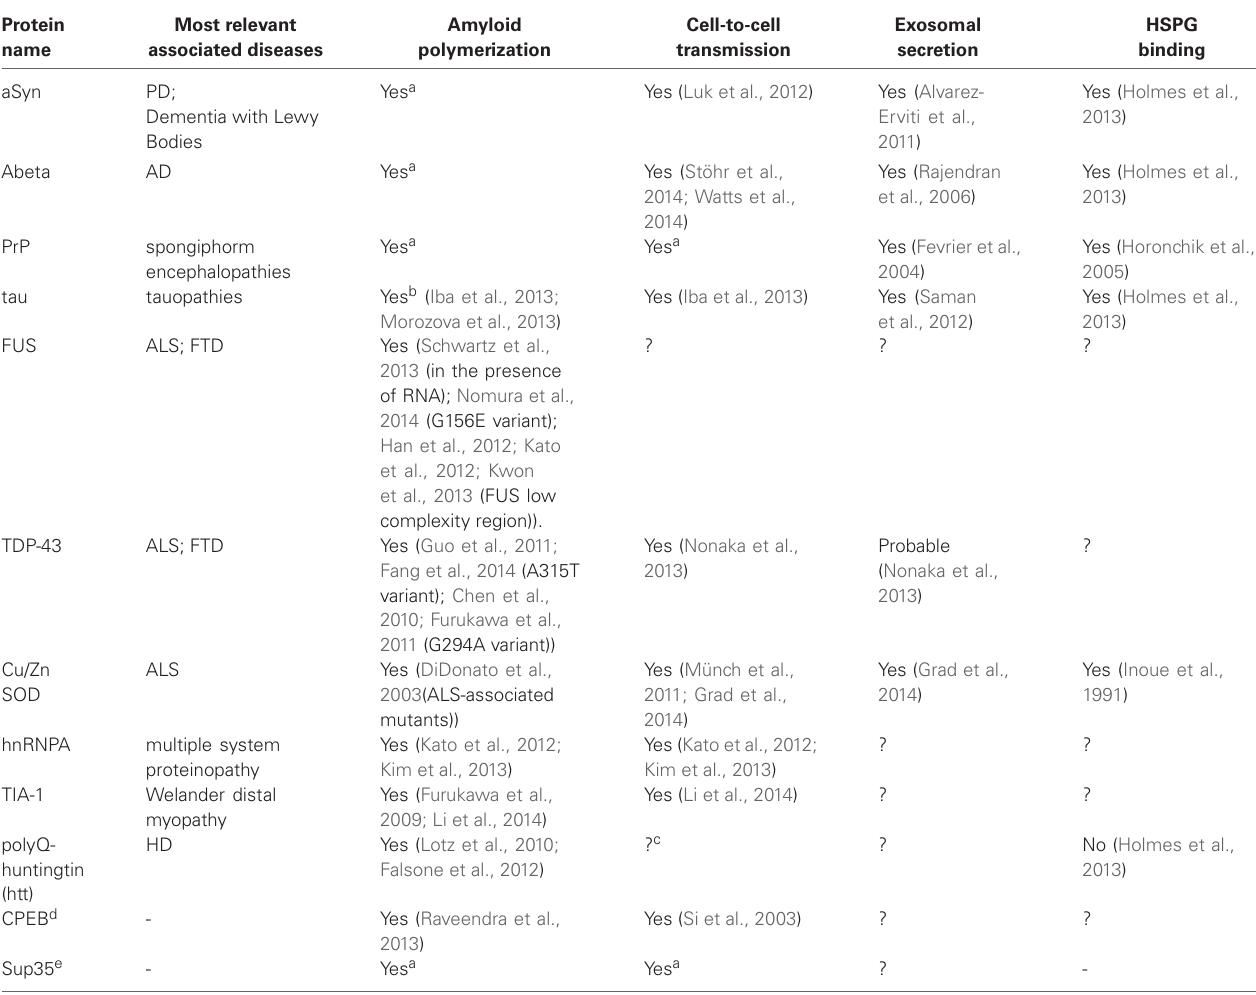
Table 1 | Summary of representative proteins handled within this review, with respect to pathology, and prion/prion-like properties . Protein Most relevant associated diseases